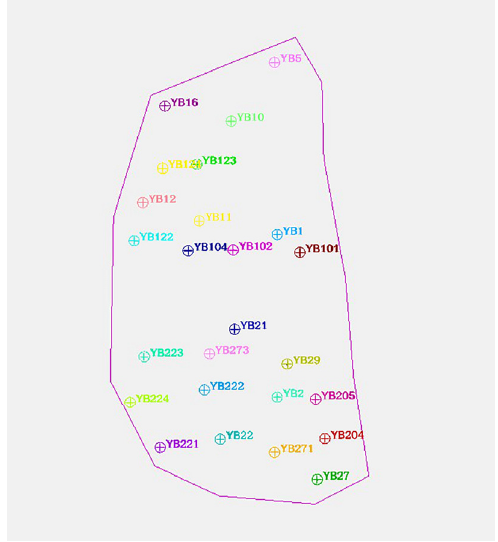
Figure 3. Scope of work area.